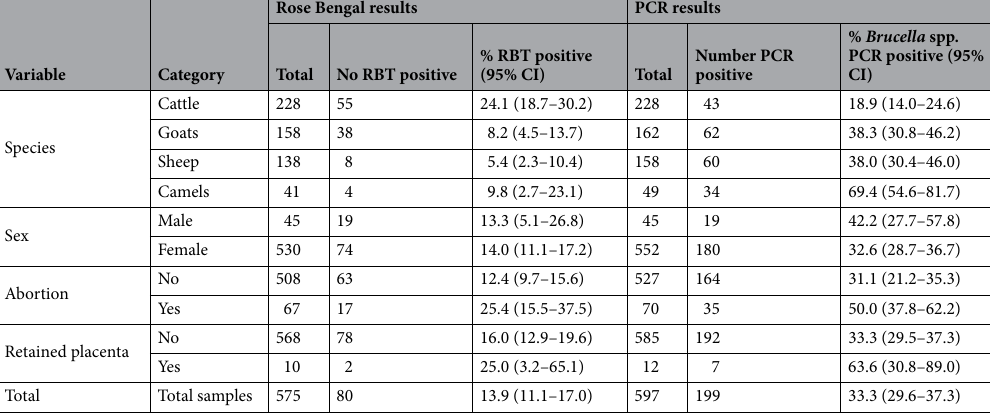
Table 1. Summary of livestock population composition, descriptive characteristics, RBT results and Brucella spp. PCR results. PCR polymerase chain reaction, CI confidence interval, RBT Rose Bengal Test.